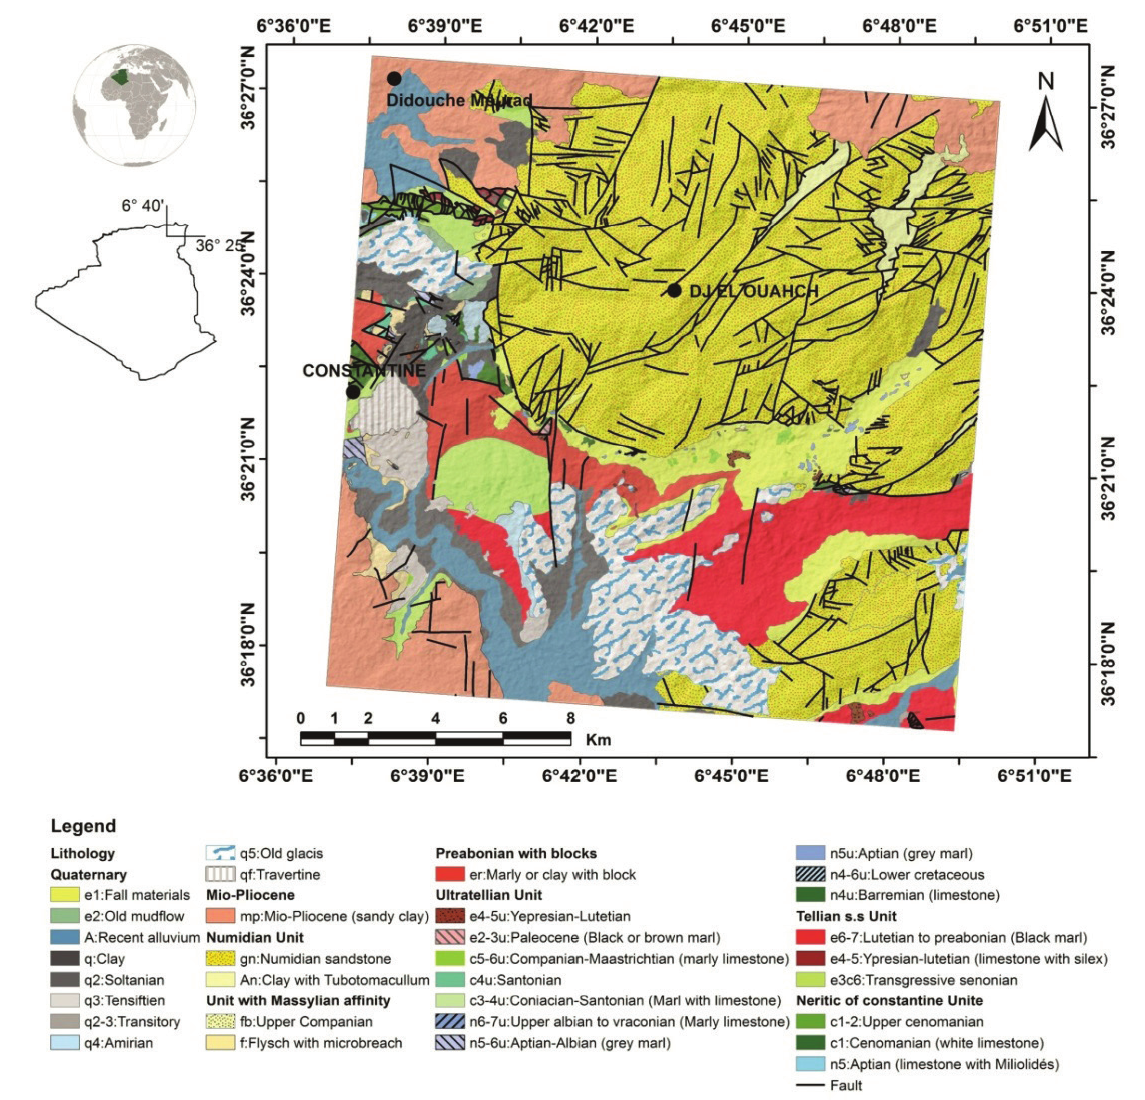
Figure 1: Geological map of the study